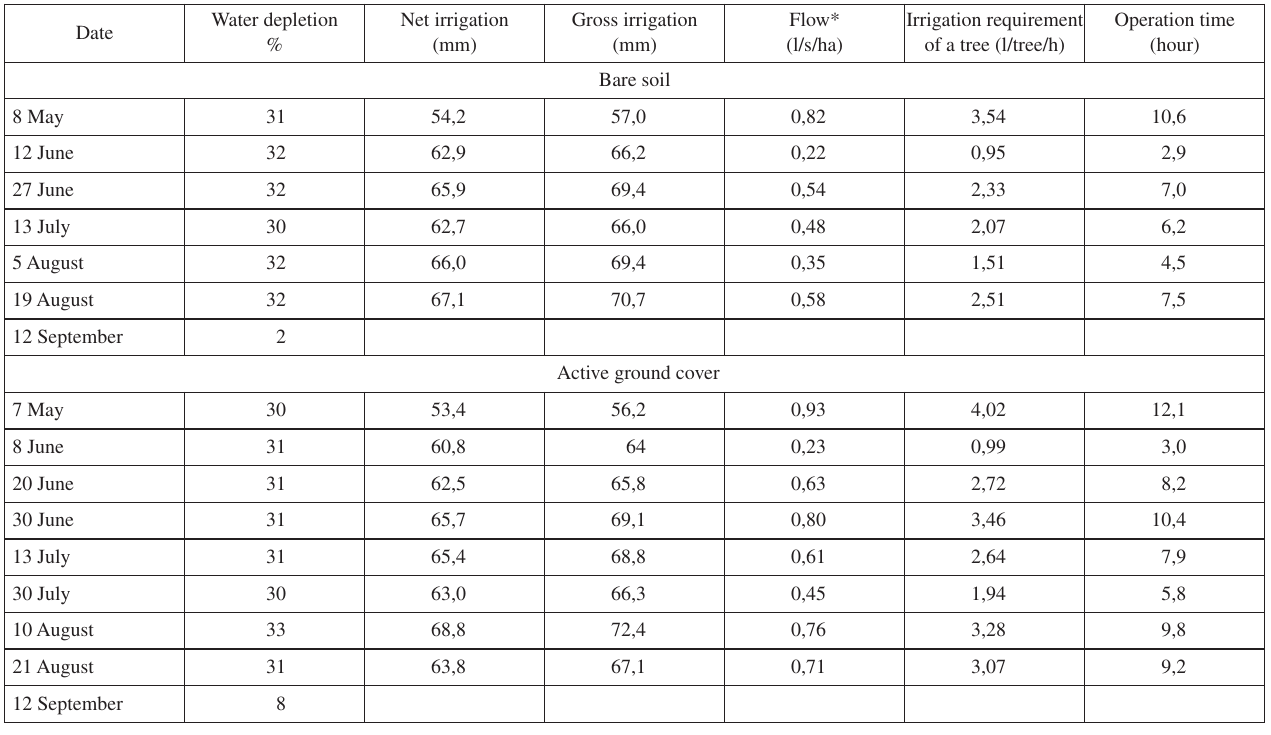
Table 1. The irrigation requirement of Sweet Lady in the driest